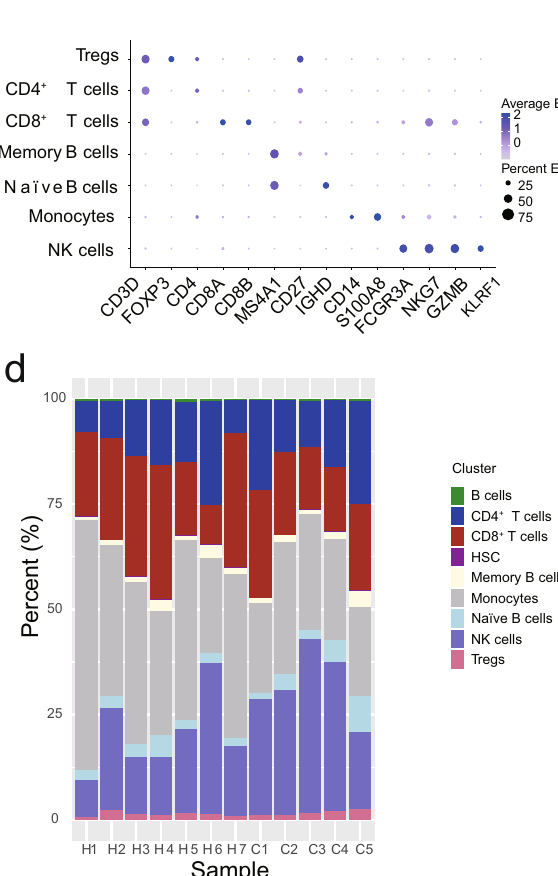
two-sided p values from the Wilcoxon rank-sum test were shown. d Proportions of each cell type in HAPH patients ( n =7) and control participants ( n =5). HAPH